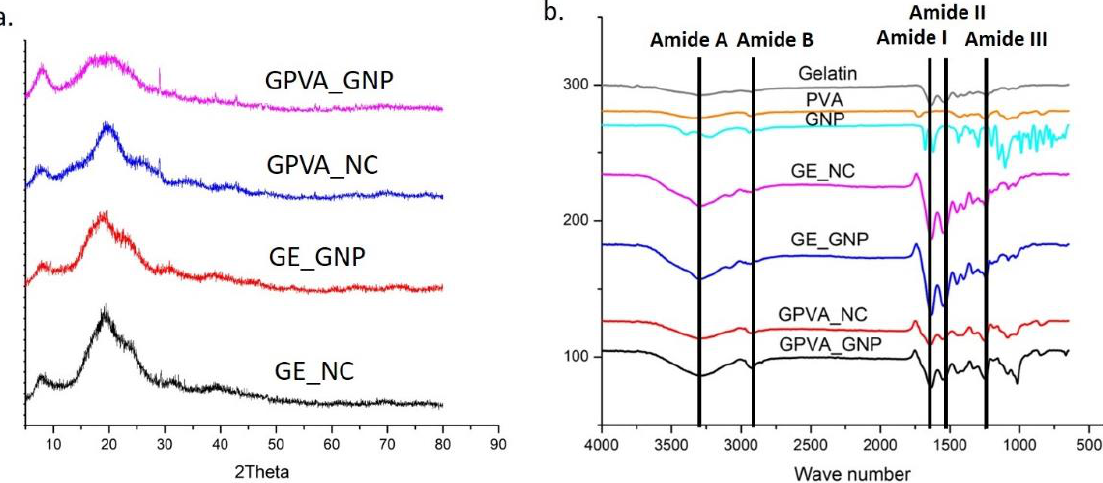
Figure 2. Chemical characterisation of the 3D-printed hydrogels ( a ) X-Ray diffraction analysis (XRD), and ( b ) Fourier transform infrared (FTIR). Table 1. Amorphous and crystallinity index for GPVA hydrogels.